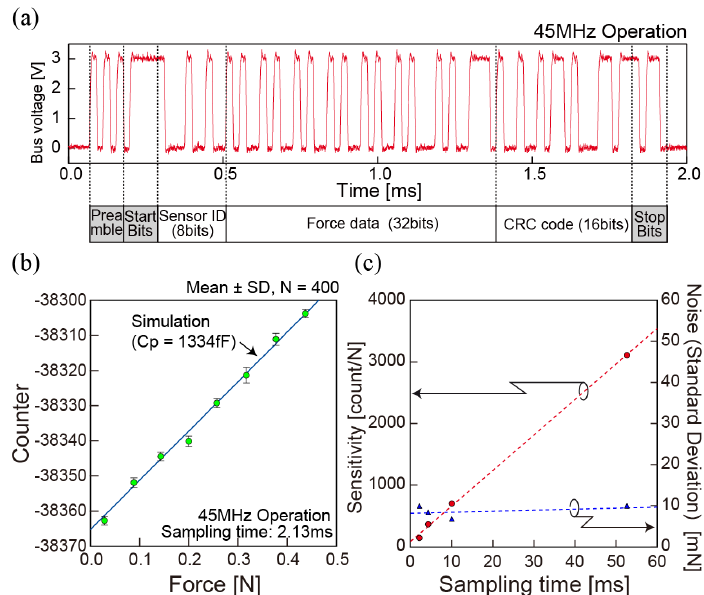
Figure 8. Experimental data with prototyped sensors: ( a ) a 45 MHz digital packet; ( b ) linear correlation between encoded counter value and external force; ( c ) sensitivity and data fluctuation with various sampling times.